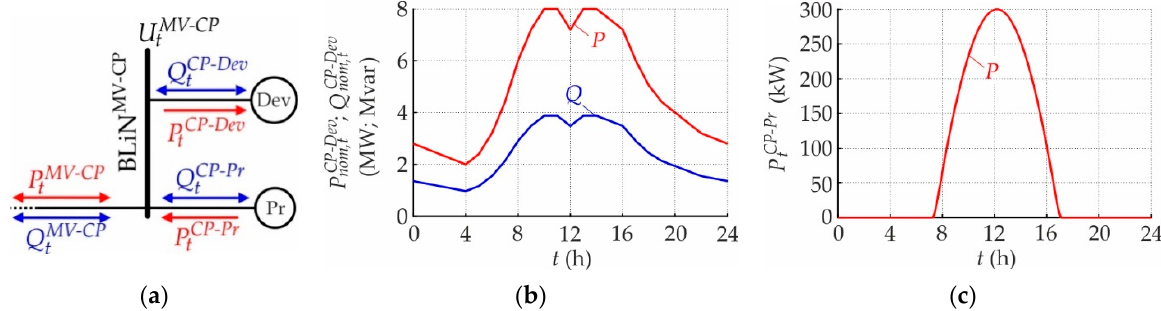
the profile shown in Figure A2c, and its reactive power contribution depends on the applied Volt/var control strategy. In the case of CP_ Q -Autarky, an additional (lossless) RPD is added to enable the full compensation of the reactive power flow through the BLiN MV-CP .